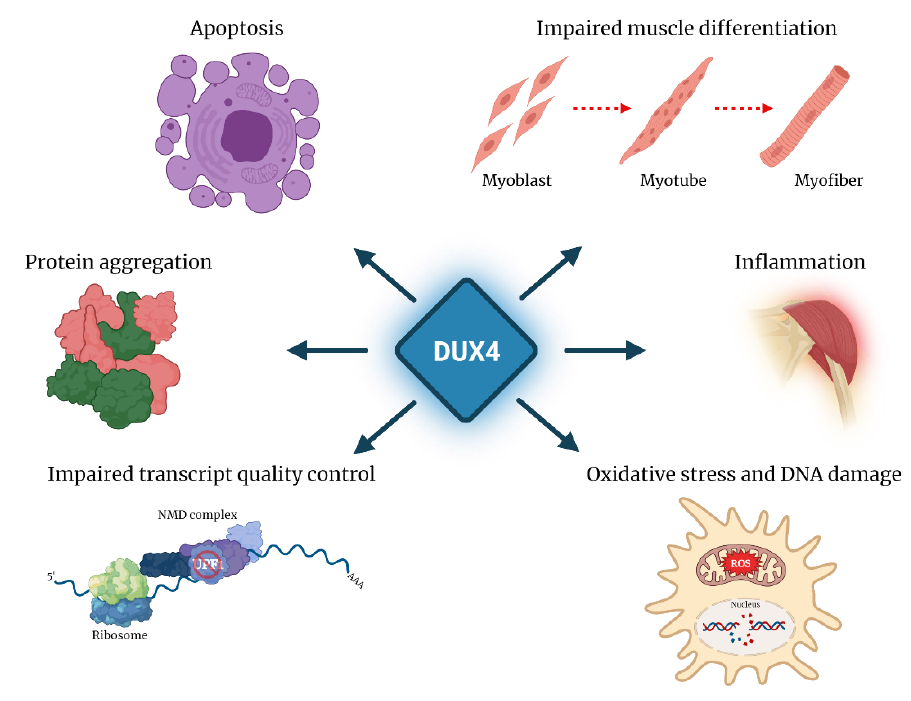
Figure 4. Pathological outcomes of DUX4 aberrant expression. DUX4 expression in FSHD is associ- ated with the activation of toxic pathways, such as inhibition of myogenic differentiation, inflam- mation, oxidative stress and DNA damage, impaired transcript quality control, protein aggregation and apoptosis.